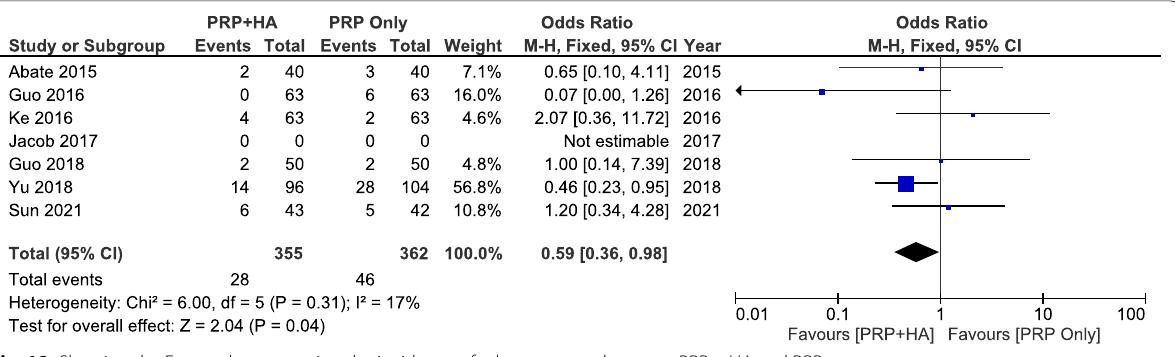
Fig. 18 Showing the Forest plot comparing the incidence of adverse events between PRP